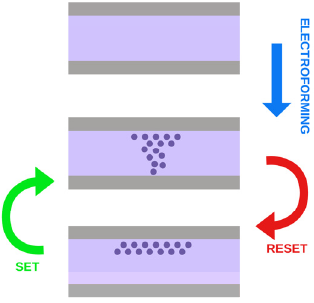
Figure 2. Process of electroforming, SET and